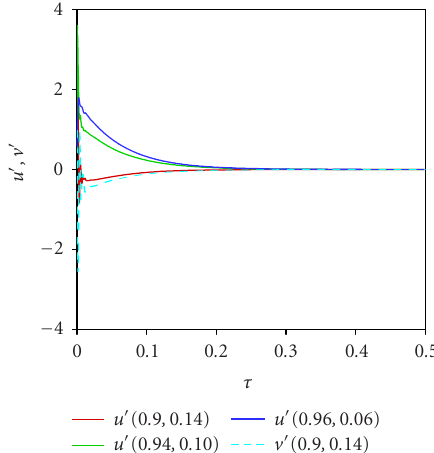
Figure 5: Dynamic responses of the solution at L 2 = − 15 on AS 1 to finite random disturbances: stable steady multicell solutions ( σ = 0 . 02, Pr = 0 . 7, Dk = 300, and L 1 =